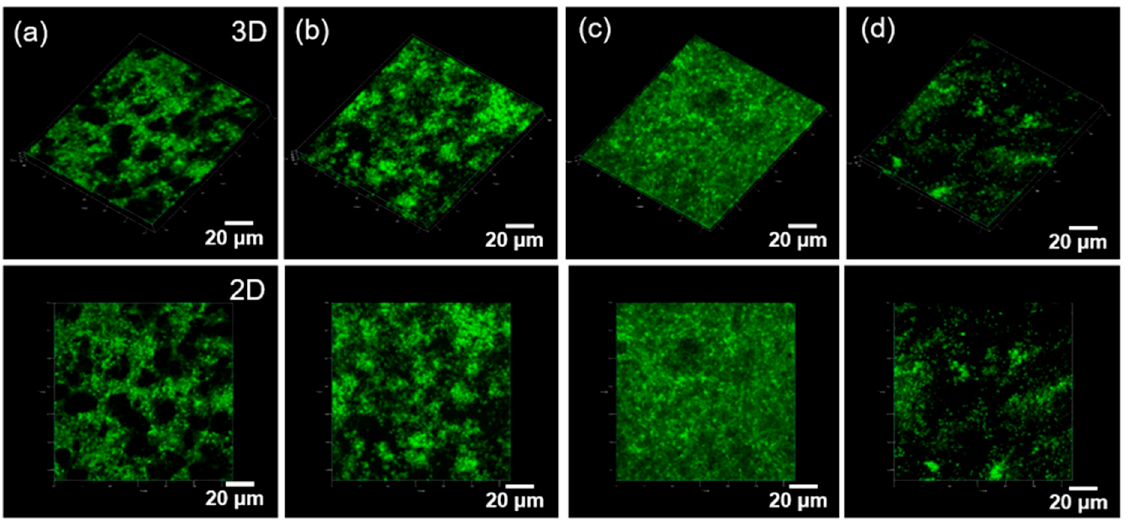
Figure 6. Fluorescence microscopy images of live cells stained with calcein-AM on ( a ) CE, ( b ) CEPP10, ( c ) CEPP20, and ( d ) CEPP50 monoliths after culturing for 5 days plus laser irradiation. ROS can induce significant cytotoxicity upon reaching an intracellular threshold concentration, leading to cell death through apoptosis or necrosis by irreversible biomolecular damage [27]. However, low levels of intracellular ROS promote cell proliferation. Therefore, the production amount of ROS is a very important factor for nerve tissue regeneration. The intracellular ROS generation in S16 cells after laser irradiation was determined with a flow cytometer using 2 ′ ,7 ′ -dichlorodihydrofluorescein diacetate (DCF-DA) as a fluorescent indicator. DCF-DA can permeate live cells and is rapidly changed by ROS to green, fluorescent DCF [28]. DCF fluorescence intensity increased with increasing immobilized PpIX content on the monoliths, with the CEPP50 monolith exhibiting a significantly high